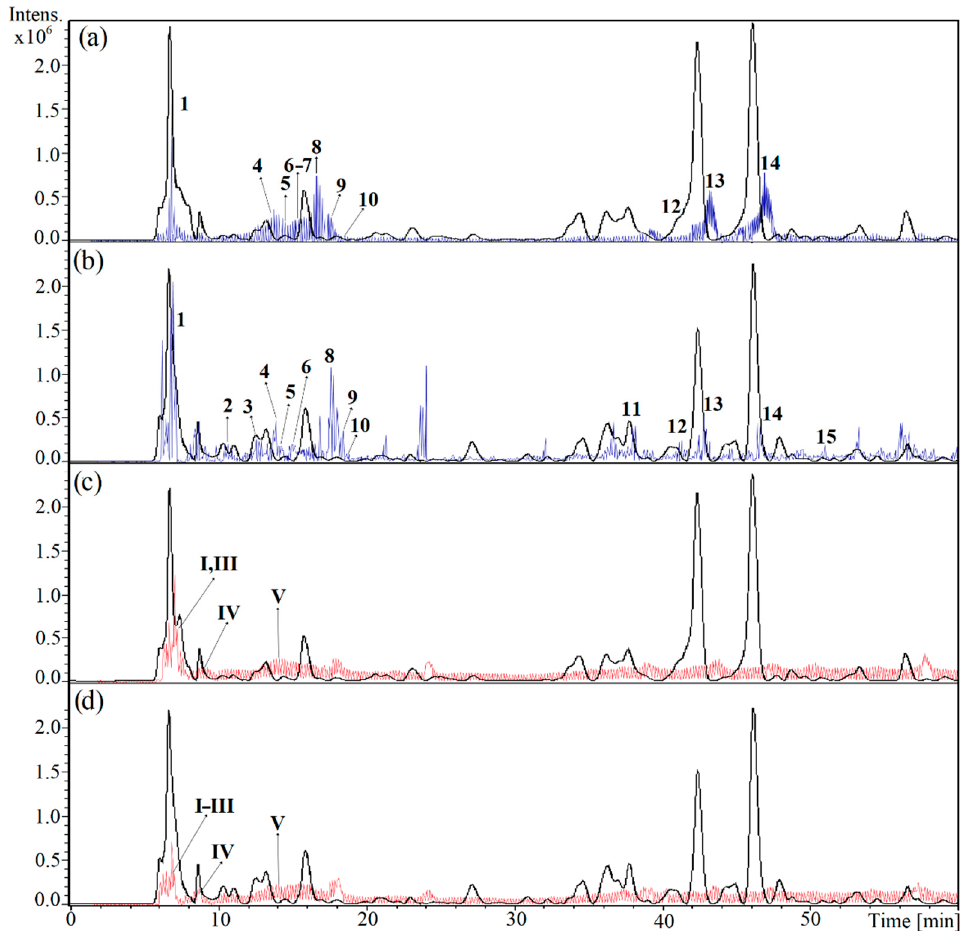
Figure 4. Ion chromatogram in the negative ionization mode (blue trace) and positive ionization mode (red trace), and HPLC profile at 280 nm of the root ( a , c ) and stem ( b , d ) extracts from the Paraguayan crude drug ysypó hû. Numbers refer to Table 4.